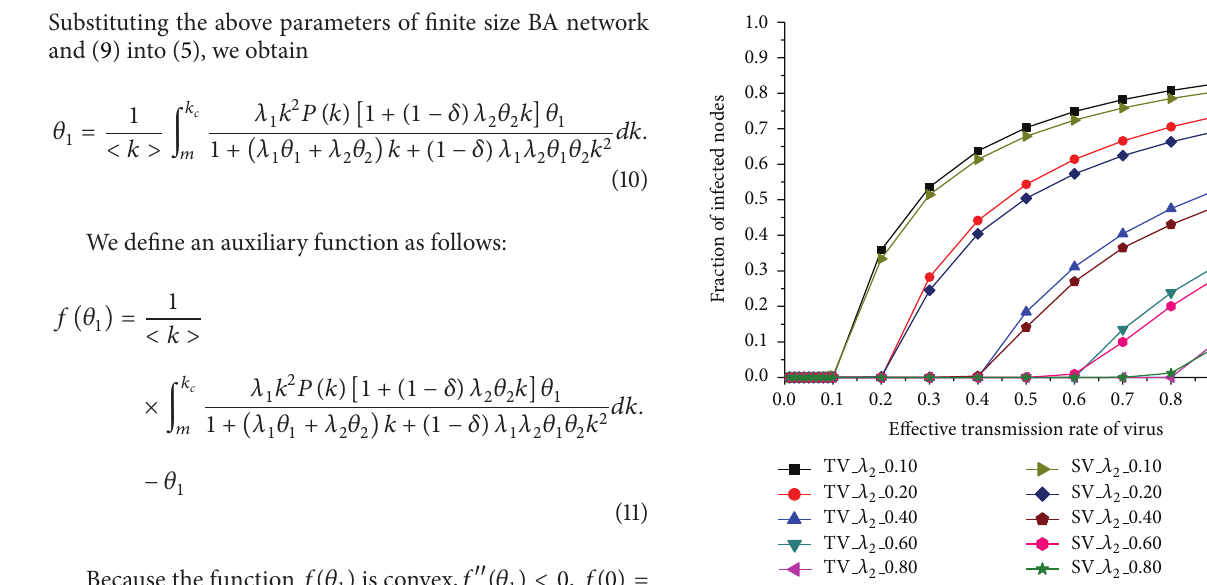
Figure 3: The node density 𝜌 (1) infected by virus as a function of virus effective transmission rate 𝜆 1 , for the different effective transmission rate 𝜆 2 of immune agent, where 𝛿 = 1 . TV prefix figure legend item is theory analytical values calculated according to (19), and SV prefix figure legend item is corresponding simulation values. Networknodenumber 𝑁 = 2000 ,newedgenumberfromeachnode m = 5 , the recovery rate of the virus spread 𝛽 (1) = 0.001 , and the recovery rate of the immune agent spread 𝛽 (2) = 0.01